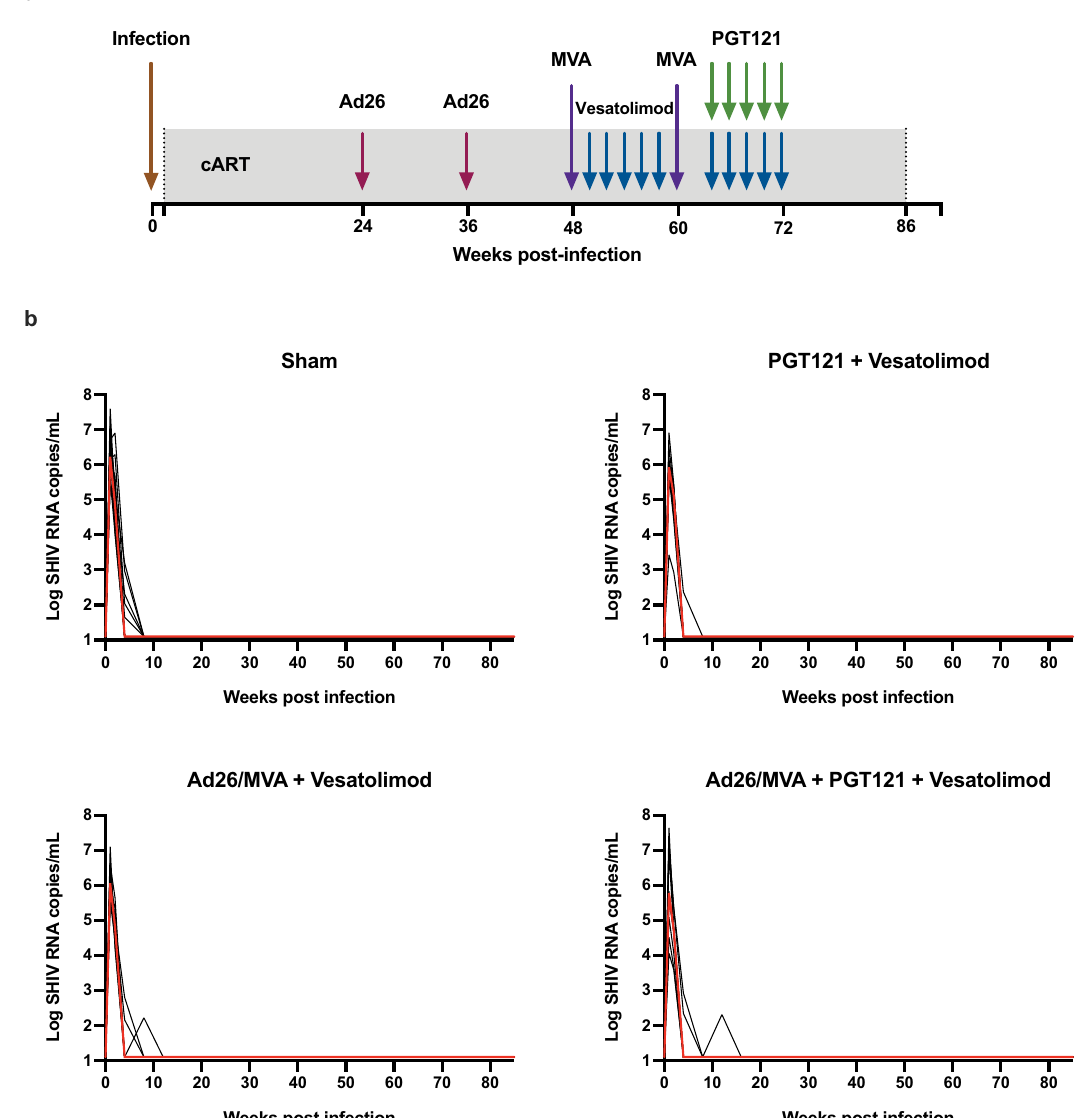
Fig. 1 SHIV plasma virus became fully suppressed in all macaques during ART administration. a Study schematic. b SHIV viral loads from infection to cessation of ART with the median viral load of each group indicated by a red